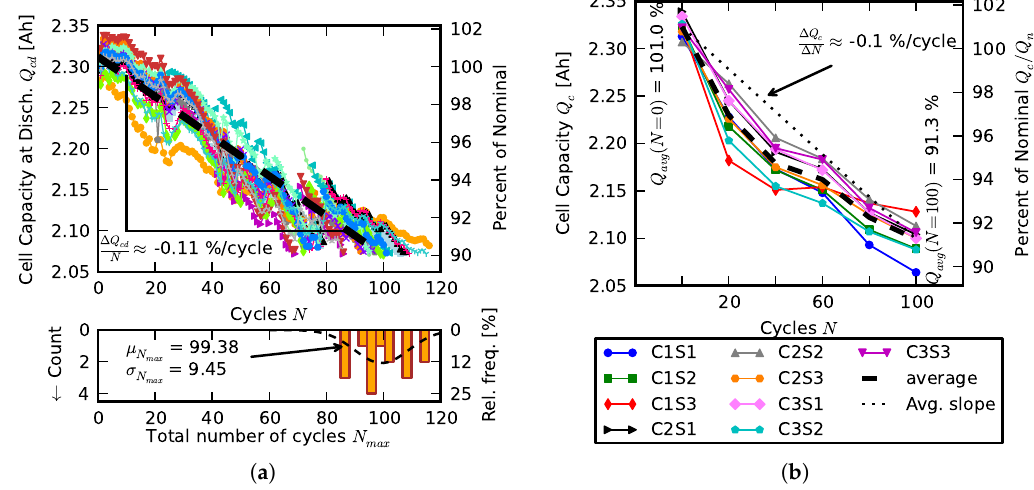
Figure 3. ( a ) capacity fade (100–90%) as function of number of cycles; ( b ) capacity fade of nine cells within a pack over 100